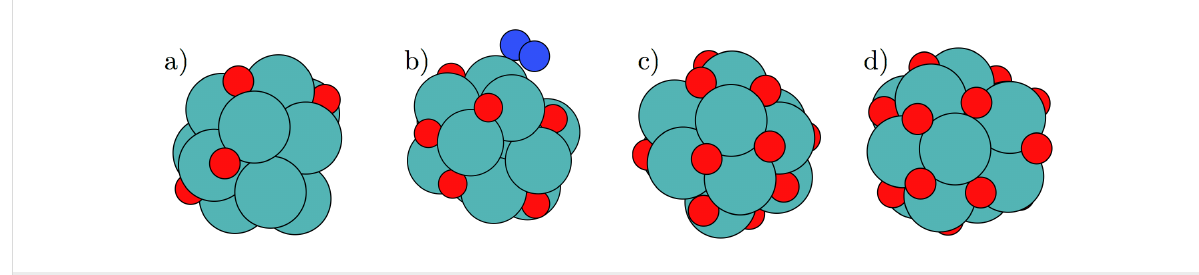
Figure 3: (a) The Mo 13 O 6 nanocluster, (b) the Mo 13 O 9 nanocluster with N 2 adsorbed, (c) the Mo 13 O 12 with an almost filled oxygen skin, (d) the Mo 13 O 16 with a filled oxygen skin. At the Mo 13 O 16 , the oxygen adsorption sites are a mix of three fold hollow sites and bridge sites.